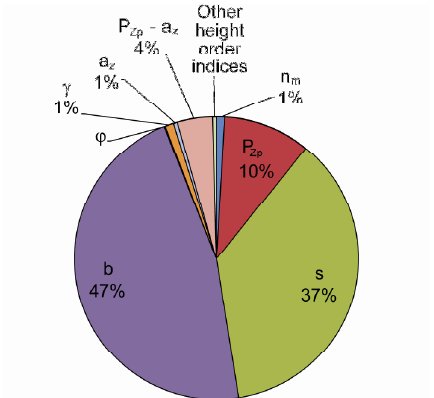
Fig. 18. Results for the second terrace ( P p is a non-random variable)